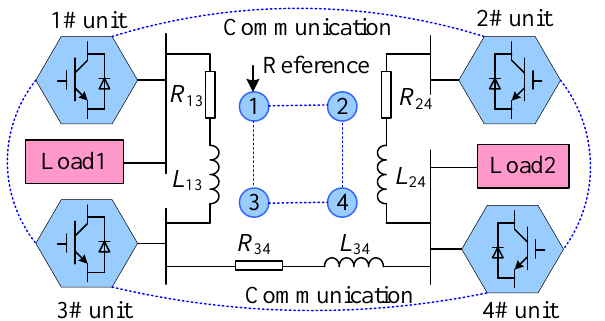
col from three aspects: